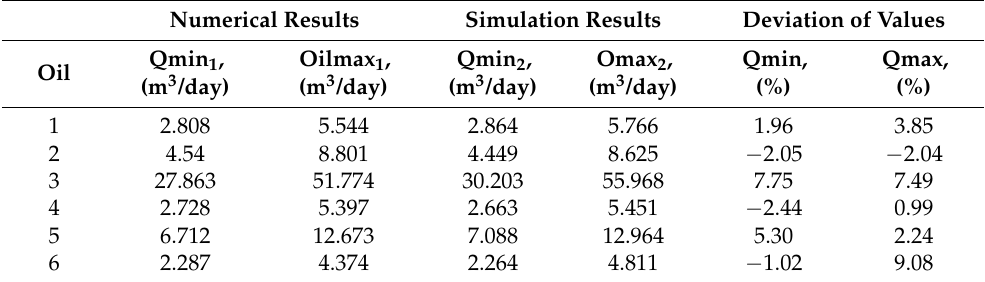
Table 5. Results of modeling the application of CSS technology using the Tempest More